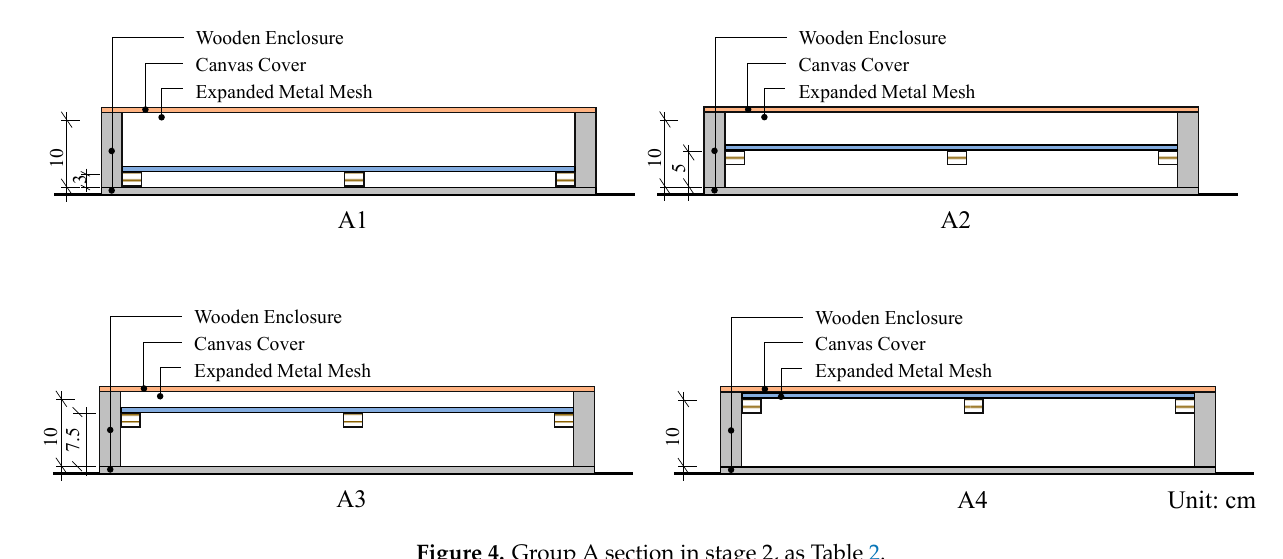
Figure 3. Specimen section in stage 1, as table 1.